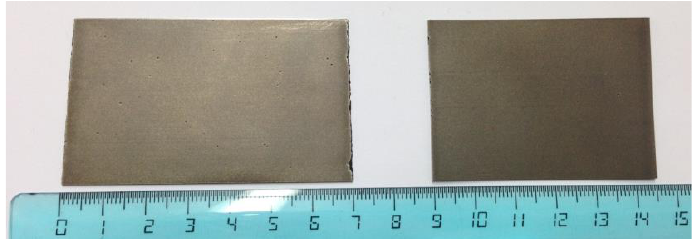
Figure 9. Picture of the two Ni 33 Ti 39 Nb 28 sheets obtained after electroerosion.